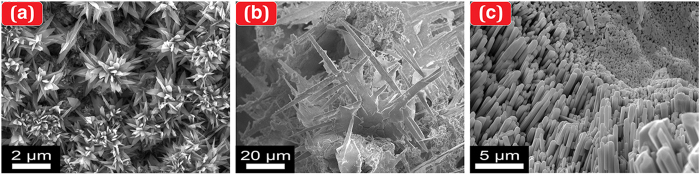
Various nanostructures of metallic oxides produced by the SPSC method.(a) CuO nanoflowers (UV24h). (b) CeO2 dendrites (Vis24h, λ ≈ 500 nm). (c) WO3 nanorods (UV48h).